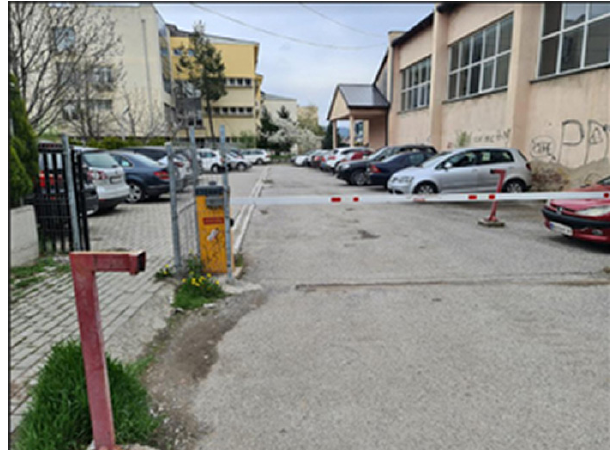
Fig. 2. Parking of vehicles without barriers entry-exit